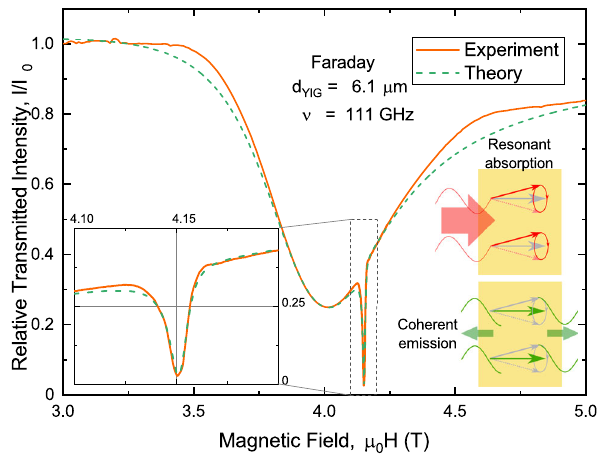
Fig. 3 Magnetic fi eld dependence of the transmission of an yttrium-iron- garnet/gadolinium-gallium-garnet (YIG/GGG) system at ν = 111 GHz frequency. On the vertical axis, the transmitted light intensity I is shown relative to the GGG substrate ’ s transmission baseline I 0 far from the paramagnetic resonance. The solid orange curve shows the experiment and the dashed green line the fi t using the Fresnel equations 44 . The broad minimum around a magnetic fi eld of 4.0 T corresponds to the paramagnetic resonance in GGG, while the sharp minimum at 4.15 T is due to the ferrimagnetic resonance in YIG. The inset shows the expanded view of this resonance in YIG. The underlying physical processes, namely resonant magnetic absorption and coherent emission, are depicted in the schematic cartoons.